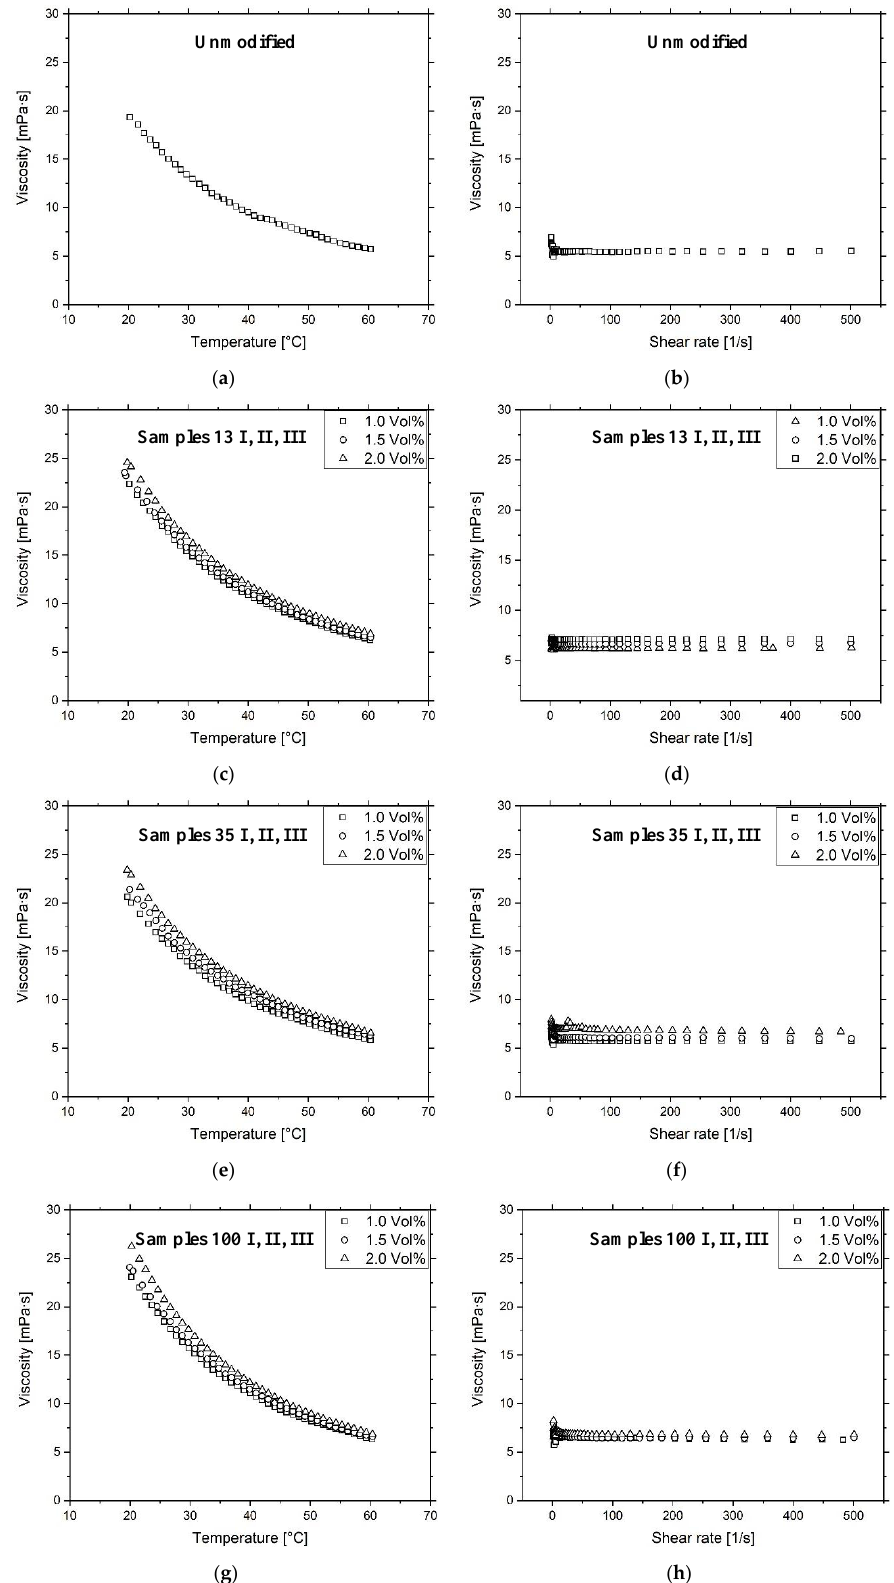
Figure A2. Rheology curves of the investigated inks in dependency of the temperature at a constant shear rate of 500 s −1 and in dependency of the shear rate at a constant temperature of 60 °C. The samples are Unmodified ( a , b ), 13 I, 13 II, 13 III ( c , d ), 35 I, 35 II, 35 III ( e , f ) and 100 I, 100 II, 100 III ( g , h ).